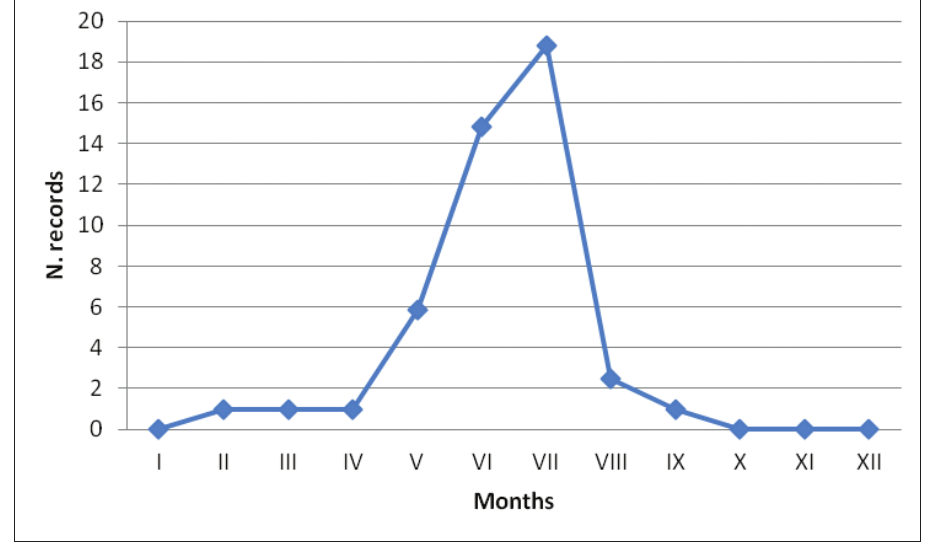
Figure 2. Italian phenology of Lichenophanes varius